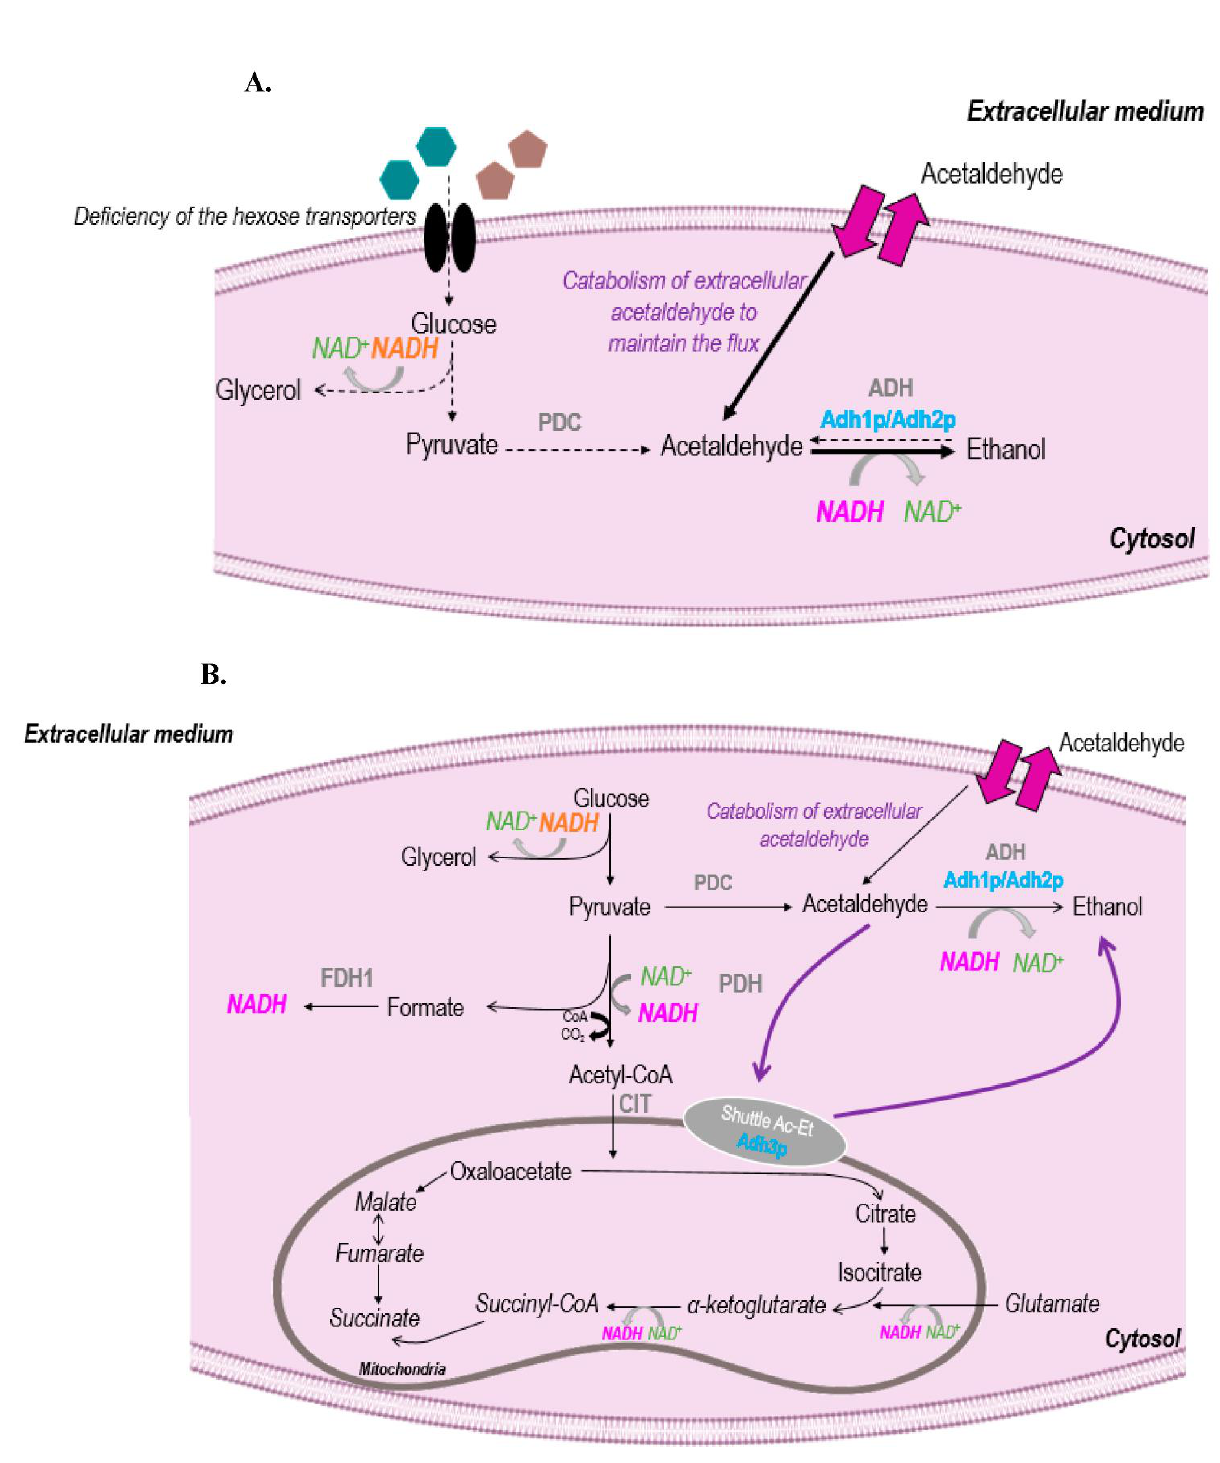
Figure 5. Hypotheses regarding the biological phenomenon of acetaldehyde reconsumption ( A ) through the decreased activity of hexose transporters and ( B ) through the principle of the acetaldehyde – ethanol Adh3p (Ac-Et) shuttle and the importance of the amount of NADH for yeast metabolism.